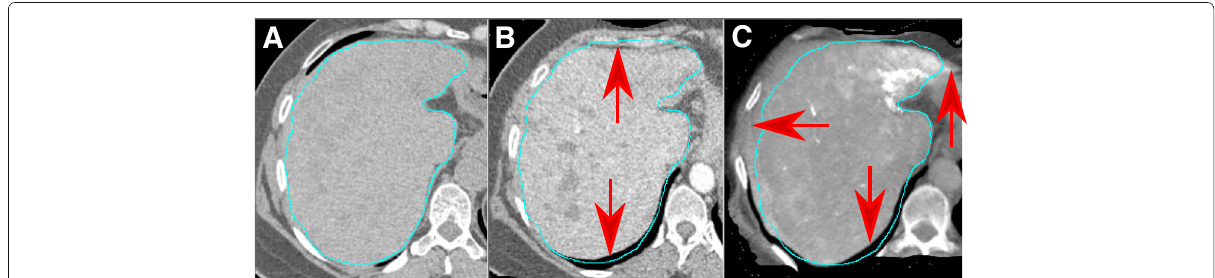
Fig. 7 An example (patient ID BI02 from training set in our database) of mis-registration for CT FDG and CBCT to CT MAA non-rigid registration (Likert score for this patient is “little misalignment,” contours come from automatic liver segmentation and red arrows point to mis-registration area. a Reference image (CT MAA ), b deformed CT FDG , c deformed meta-CBCTs